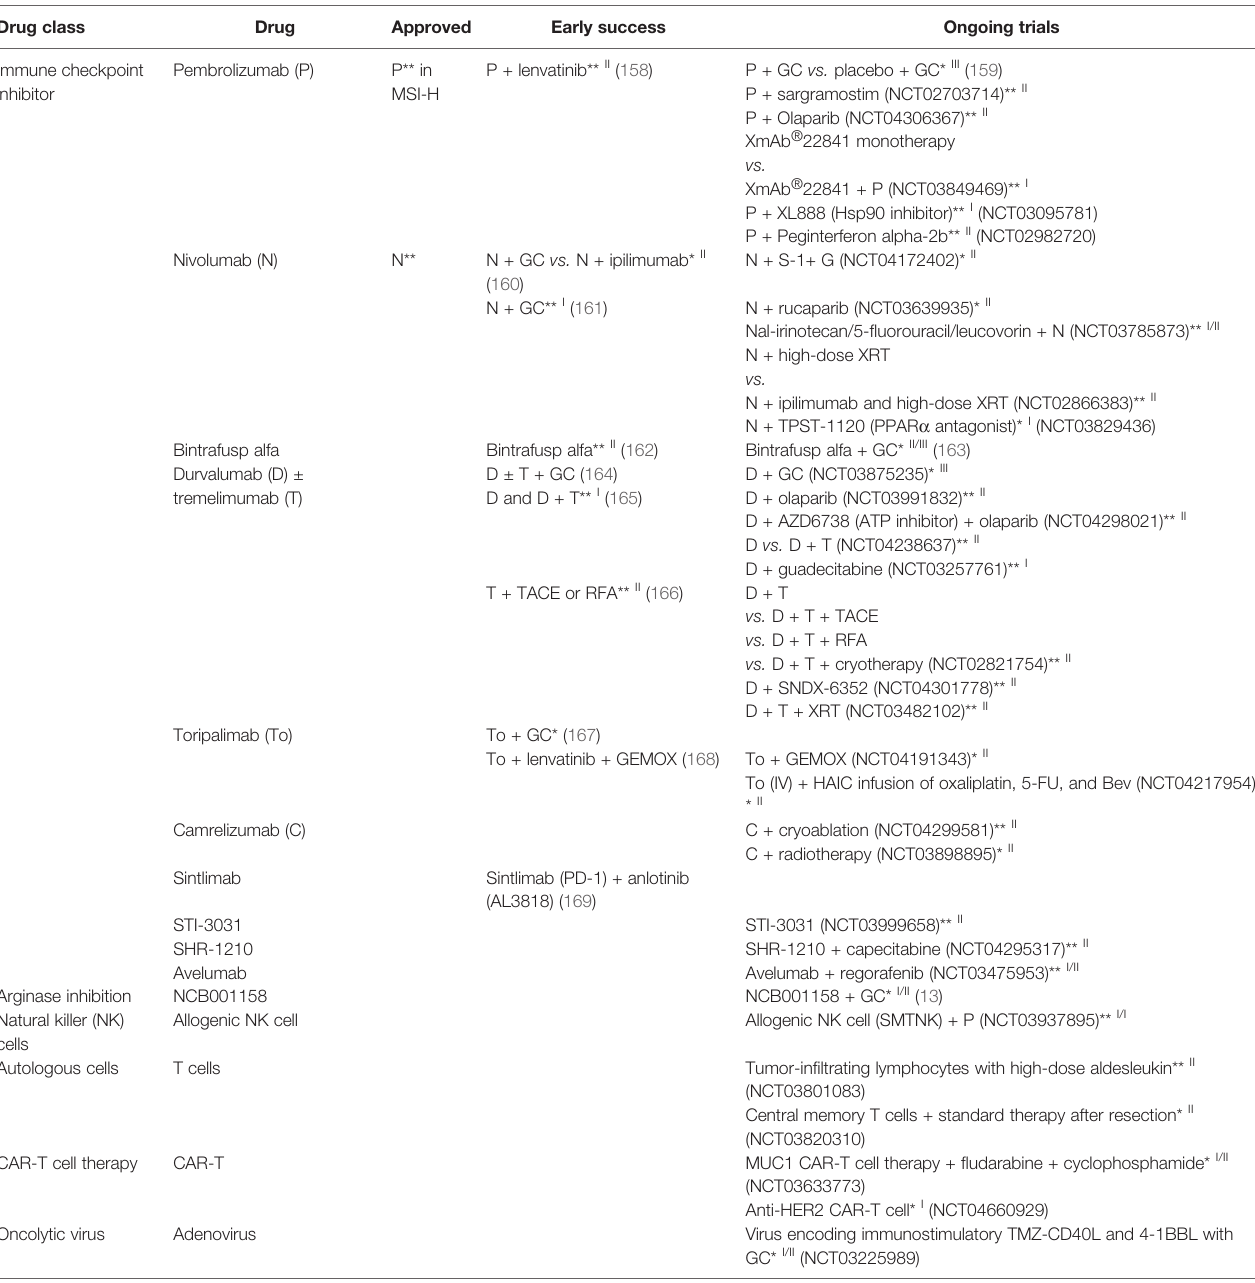
TABLE 5 | Immunotherapy in biliary tract